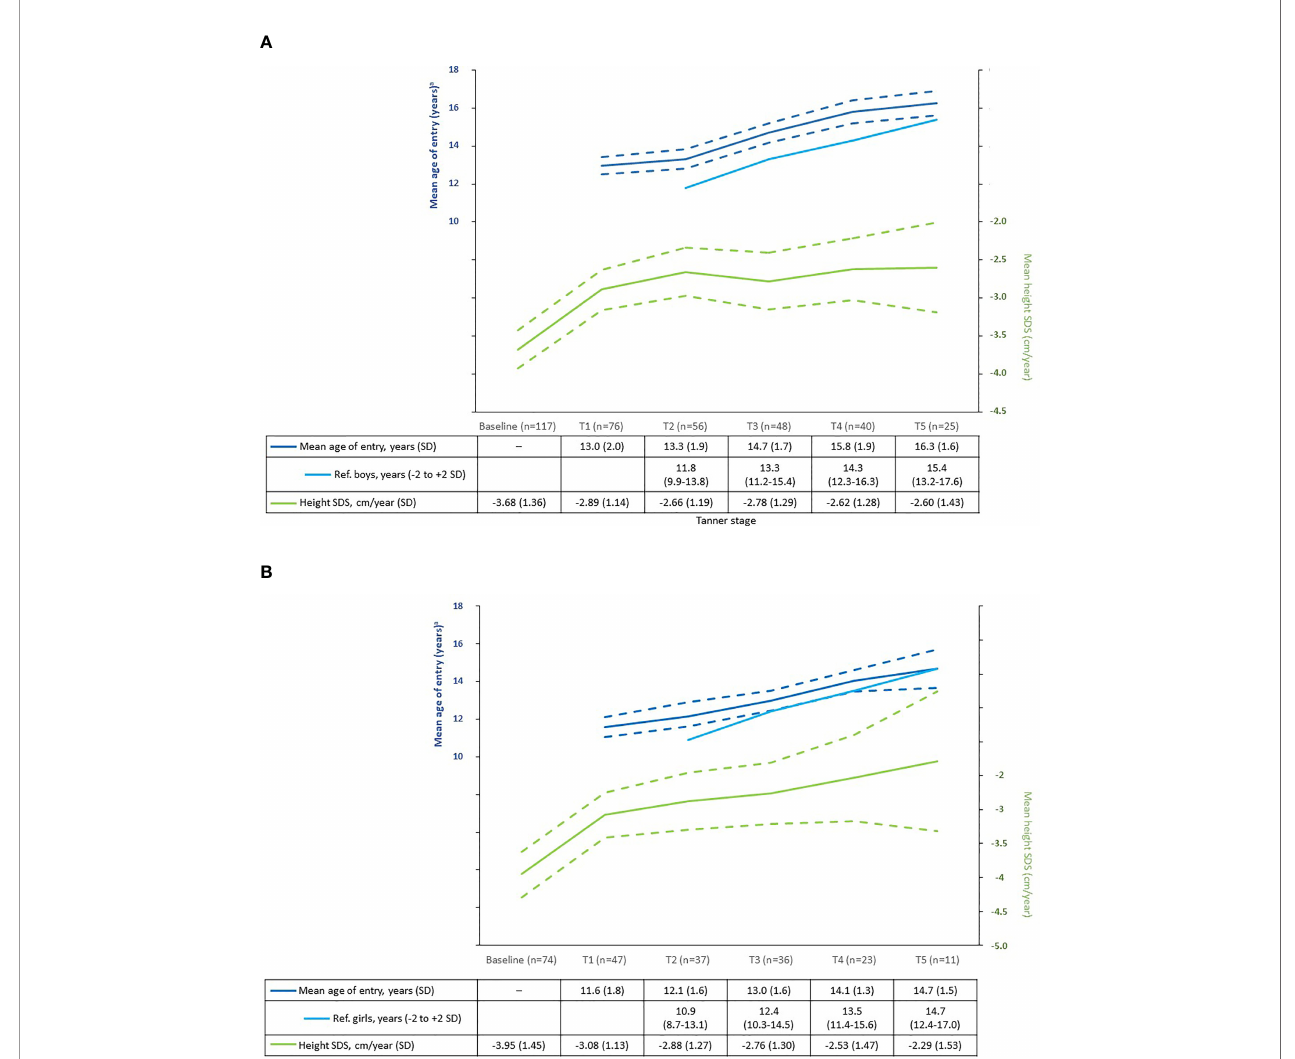
FIGURE 1 | Mean age of entry into Tanner stage* and mean height SDS at each Tanner stage in rhIGF-1-treated children compared with reference population (18). (A) Boys. (B) Girls. Reference population: healthy Caucasian children from public schools in Denmark between 1991 – 1993. A total of 826 boys and 1100 girls (aged 6.0 to 19.9 years) were included. Dashed lines show 95% con fi dence intervals for the Eu-IGFD Registry population. *Except T1 values, which are age at last T1. a For children in the Eu-IGFD Registry, this was the mean age at fi rst registration into each Tanner stage. SPIGFD, severe primary insulin-like growth factor-1 de fi ciency; SD, standard deviation; SDS, standard deviation score.